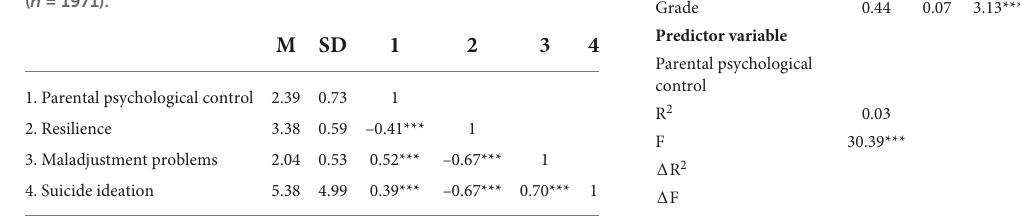
TABLE 1 Descriptive statistics and Pearson correlations matrix ( n = 1971).